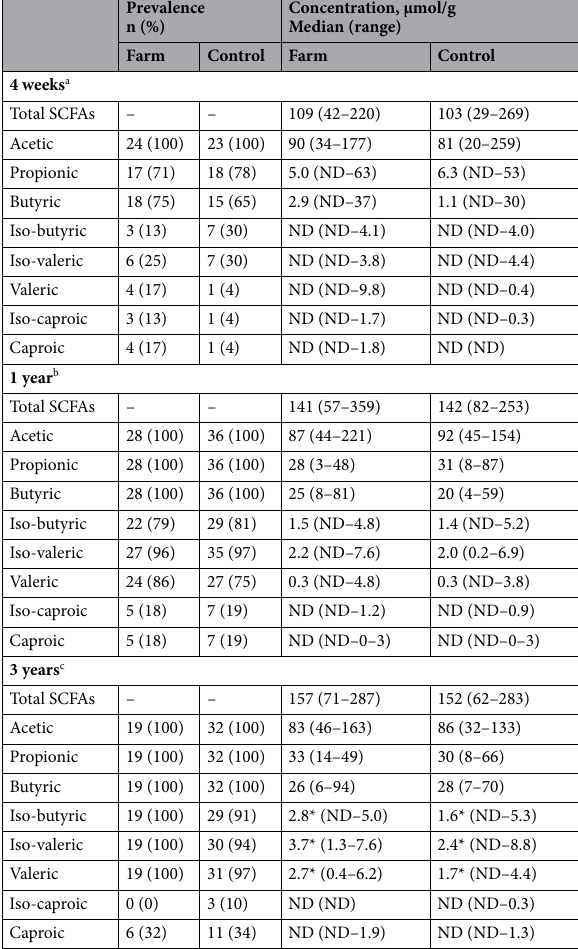
Table 2. Prevalence and concentration of fecal SCFAs in farm and control children. * P < 0.05, Chi-squared or Fisher’s exact test for counts, Mann–Whitney U-test for continuous variables. ND, not detected. Feces analyzed from: a 24 (86%) farm and 23 (62%) control children. b 28 (100%) farm and 36 (97%) control children. c 19 (68%) farm and 32 (87%) control